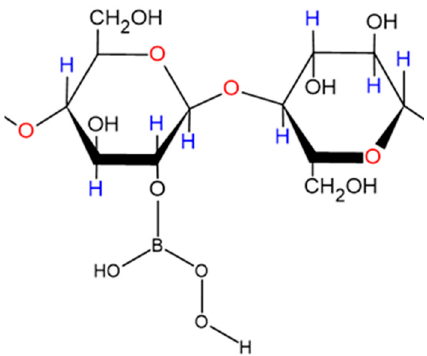
Figure 3. Proposed part-structural representation of a peroxoborate monoester adduct with straight- chain cellulose formed under conditions involving an excess of cellobiose residue concentration over that of peroxoborate.